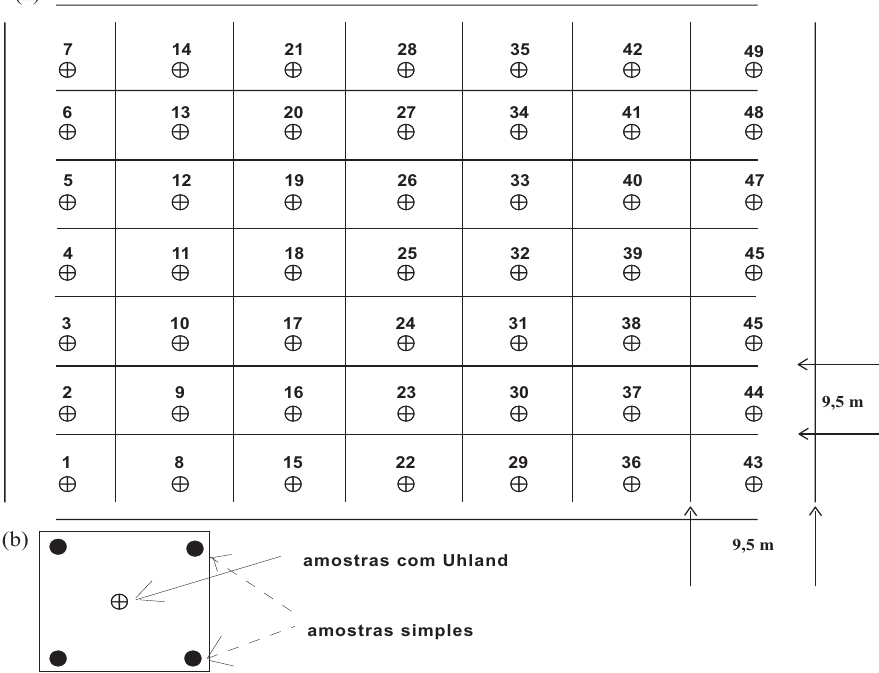
Figura 1. Croquis do campo de amostragem: cada ponto numerado representa um local de amostragem com o coletor de Uhland (a); uma célula de amostragem, indicando os locais de coleta de amostras simples